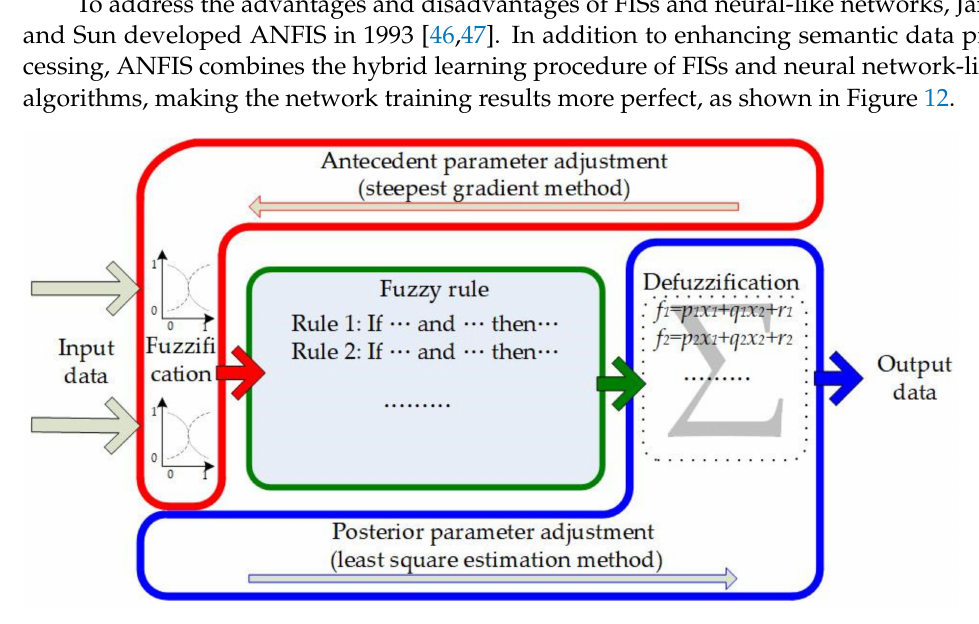
Figure 12. Schematic diagram of the composite learning